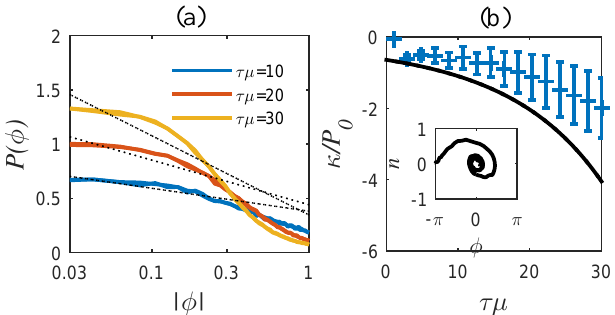
Figure 4: Same as Fig. 3, in the presence of a thermal noise at temperature T = 0.1. is